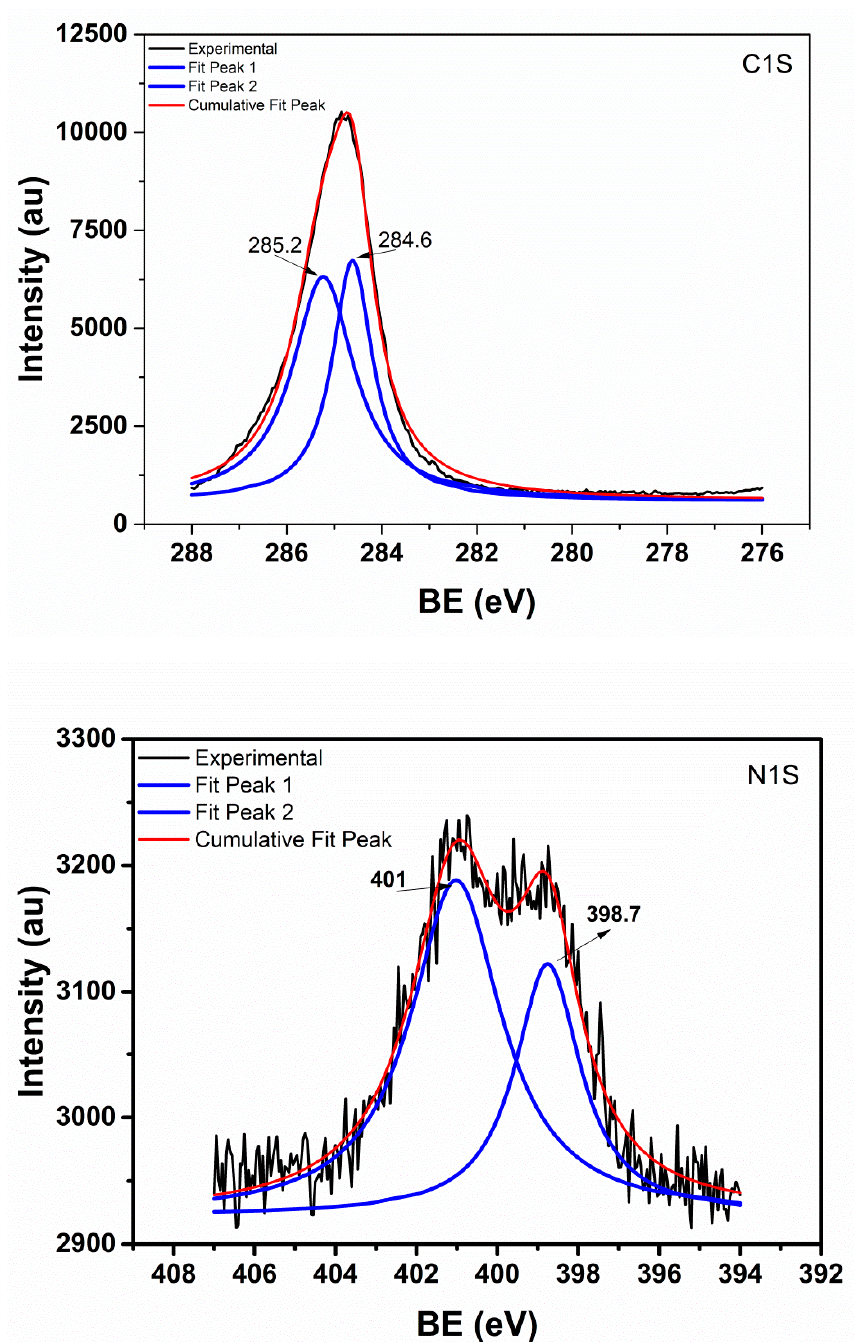
Figure 11. Deconvolution and Lorentzian fit to XPS data for C1s and N1s peaks of sample H3.